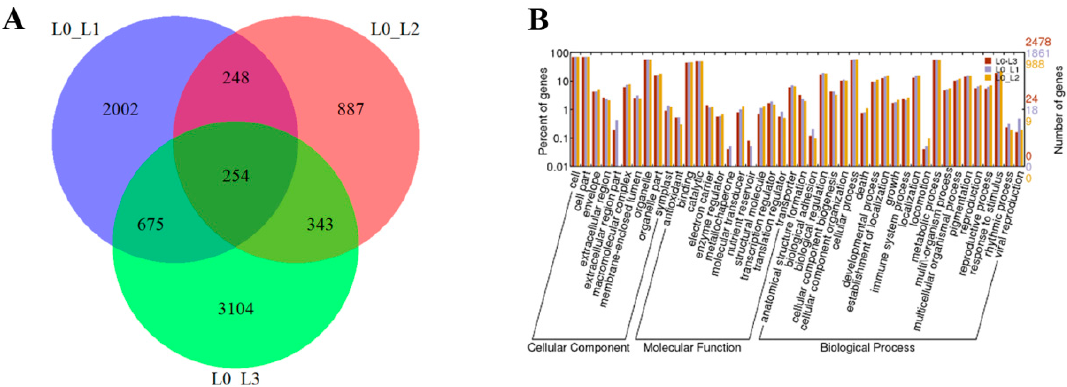
Figure 3. Numbers of shared and unique genes in L0 vs. L1, L0 vs. L2 and L0 vs. L3 ( A ) and the gene ontology classification of L0 vs. L1, L0 vs. L2 and L0 vs. L3 ( B ).